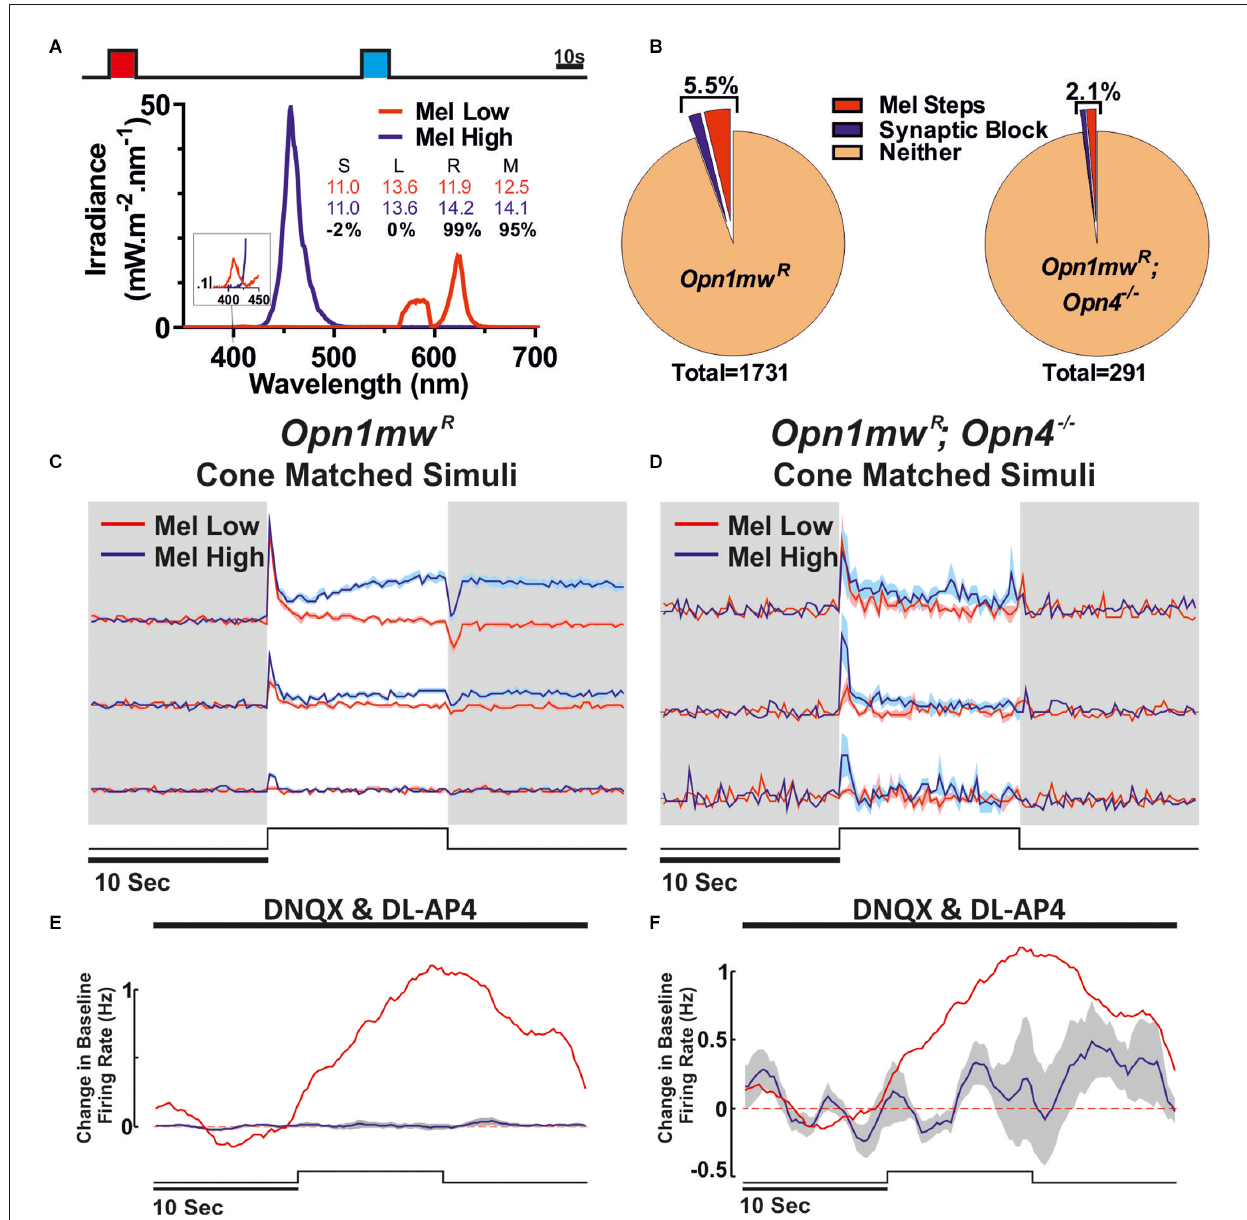
FIGURE4 Identification of melanopsin responses via cone-isoluminant light steps. (A) Stimuli presented to the mice. Melanopsin High (blue) and Low (red) stimuli were presented as 10 s light steps from darkness (80 s ISI). Respective spectra and relative photon absorbance (log 10 photons) for each photopigment is shown below. Michelson contrast between stimuli shown in black. (B) Proportions of all cells passing our criteria for ipRGC classification based on response under synaptic blockade or comparison between Mel High and Low steps in Opn1mw R ( left ) and Opn1mw R ; Opn4 -/- ( right ) mice. Data were collected in Opn1mw R mice (C,E) and animals which lacked functional melanopsin expression ( Opn1mw R ; Opn4 -/- ; D,F ). (C,D) Mean ± SEM response of units that were deemed melanopsin positive from the Mel high vs. low steps from darkness. ( C : n = 66/1,735, D : n = 4/291). (E,F) Mean ± SEM response under synaptic blockade for putative ipRGCs to a 10 s light pulse (2.5 s smoothing; stimuli and spectra Figure 3A bottom ). (E) Mean ± SEM response of cells shown in (C) . Red trace is the mean response of ipRGCs identified under synaptic block Figure 3E . (F) All cells passing either of our ipRGC classification criteria in red cone MKO mice ( n = 6).